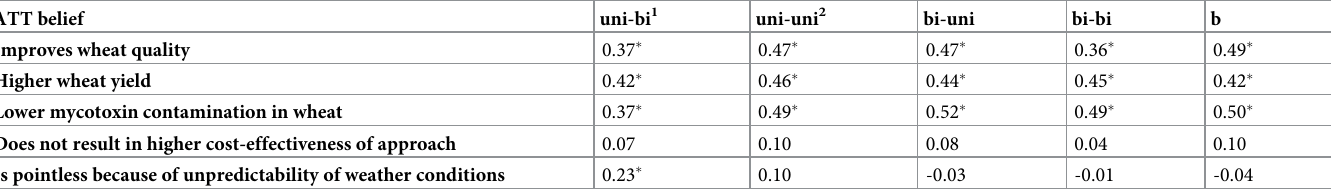
Table 6. Correlation coefficients between the ATT belief score (b) and the ATT construct, and between the four ATT multiplicative composites (uni-bi, uni-uni, bi- uni, bi-bi), and the ATT construct. ATT belief